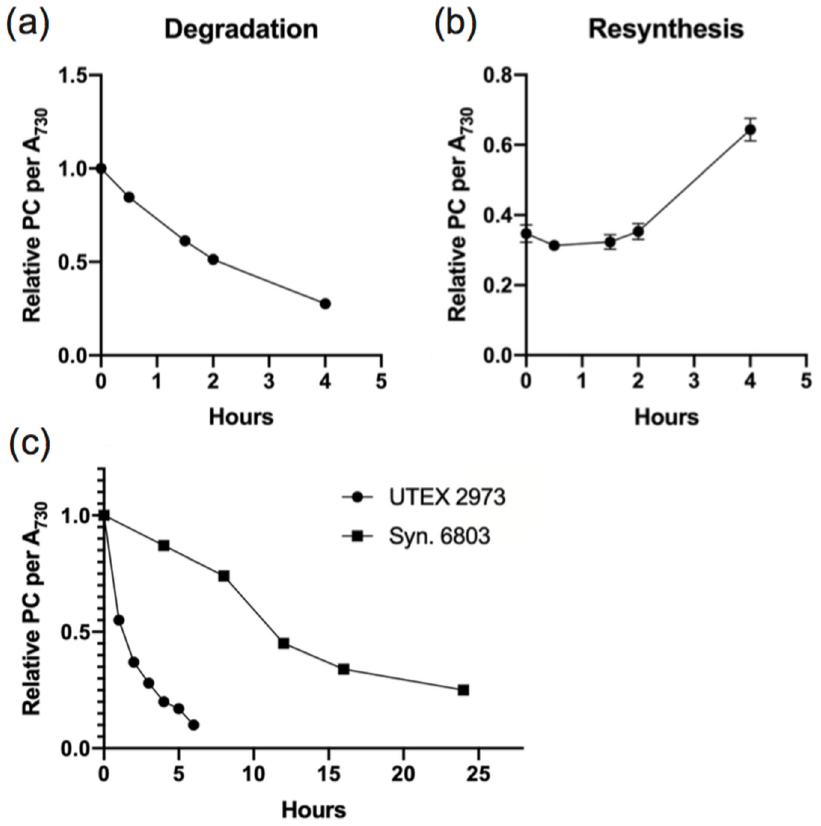
Figure 1. Degradation ( a ) and re-synthesis ( b ) of phycobilisomes (PBSs) in wild type UTEX 2973 during nitrogen depletion and repletion, respectively. Degradation and re-synthesis are calculated by the changes in relative phycocyanin (PC) content per OD 730 over time. The traces are an average of three independent biological replicates with standard deviation represented as error bars. The error is minor ( ± 0.02) at some time points and therefore not visible in the graphical representation. The raw absorbance values (400–750 nm) were recorded for each of three biological replicates at each time point, and PC concentration was calculated according to [8]. The values at time T0 were normalized to 1.00 to establish the start of the degradation experiment and values for all time points are relative to T0. ( c ) Comparison of PBS degradation in UTEX 2973 and Synechocystis sp. PCC 6803. Representative data are shown from a total of three biological replicates in UTEX 2973 and two biological replicates in Synechocystis PCC 6803.